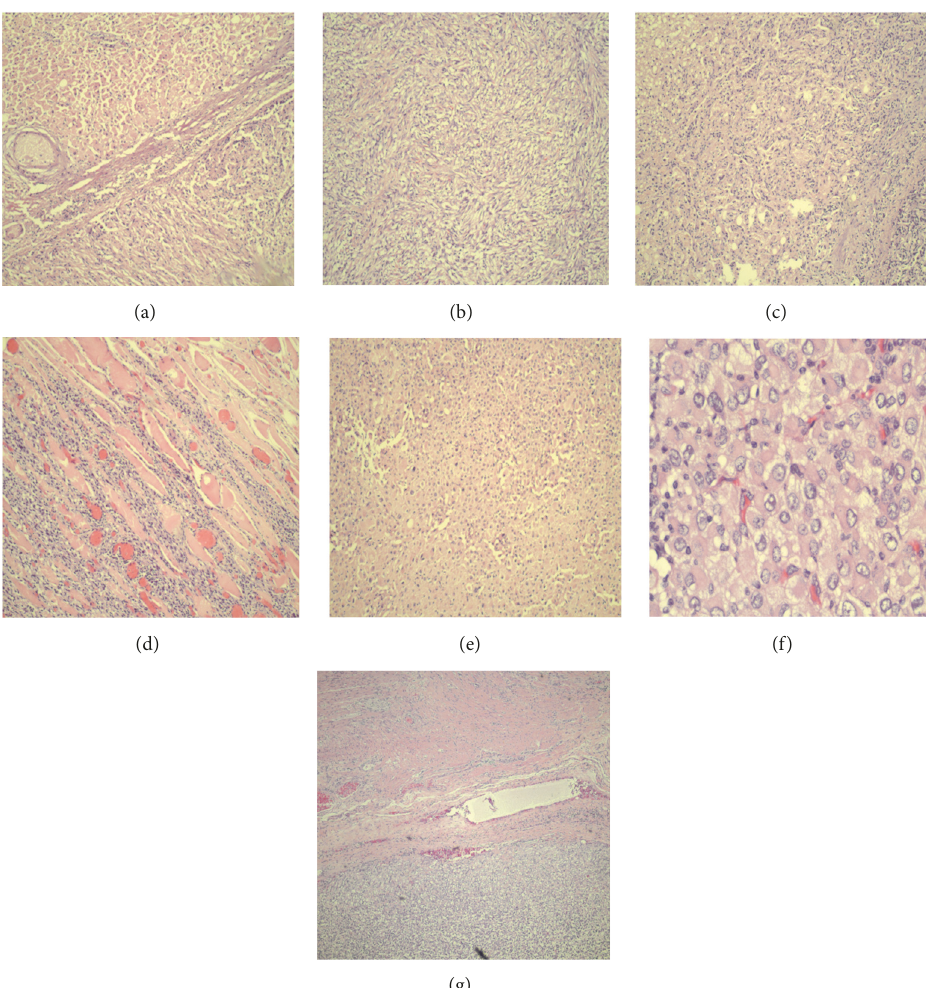
Figure 3: Microscopic findings: (a) tumor arising from surface of liver; (b) spindle cell component; (c) tumor focally invading the liver; (d) tumor invading the abdominal wall musculature; (e) epithelioid component; (f) tumor invading colonic adventitia (g) rhabdoid